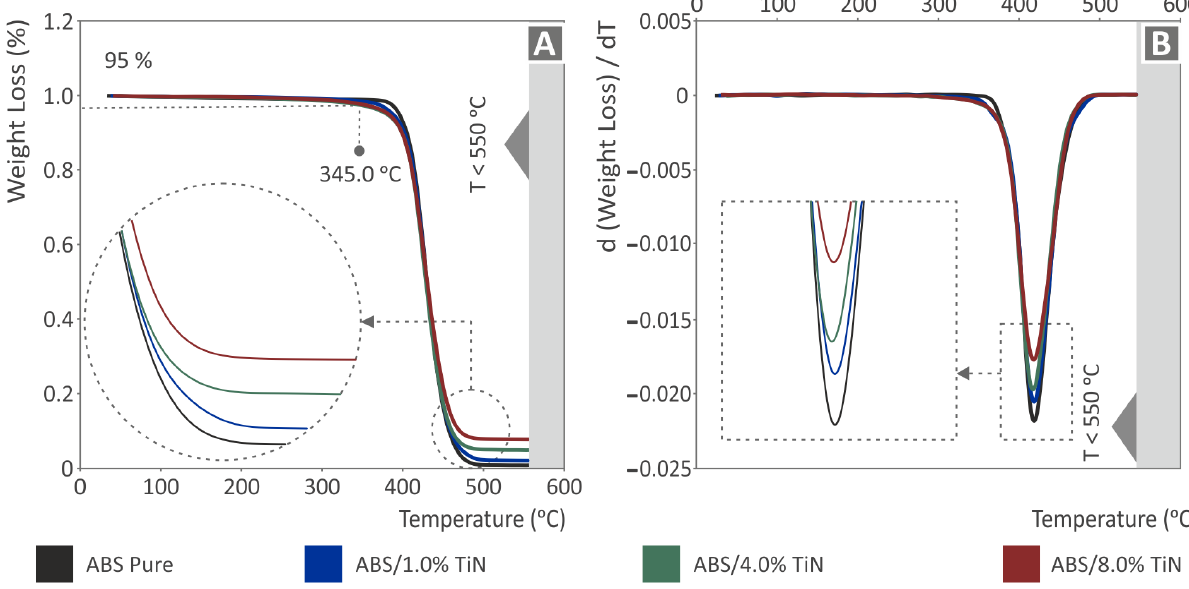
Figure 4. TGA graphs for pure ABS and ABS/TiN nanocomposites depicting ( A ) the weight loss and ( B ) its derivative for temperatures up to 550 °C.